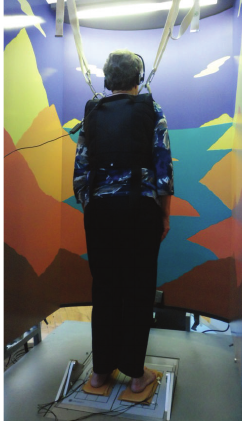
Figure 1: Position of tactors under the sole of the foot (1st and 5th metatarsal-phalangeal joint region and heel).